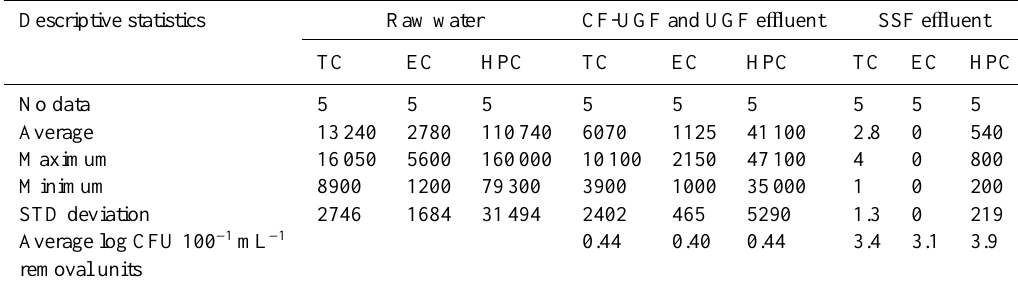
Table 7. Microbiological behaviour with the use of coagulant (UGF: V f 1 . 0mh − 1 , SSF: V f 0 . 3mh − 1 ). Descriptive